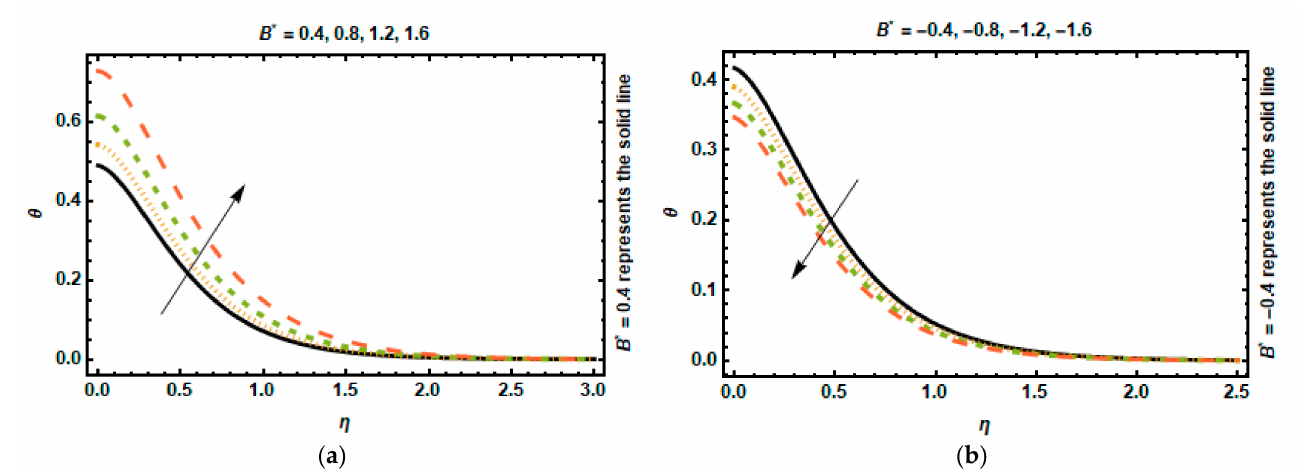
Figure 11. Effects of B ∗ on temperature. ( a ) B ∗ > 0. ( b ) B ∗ <